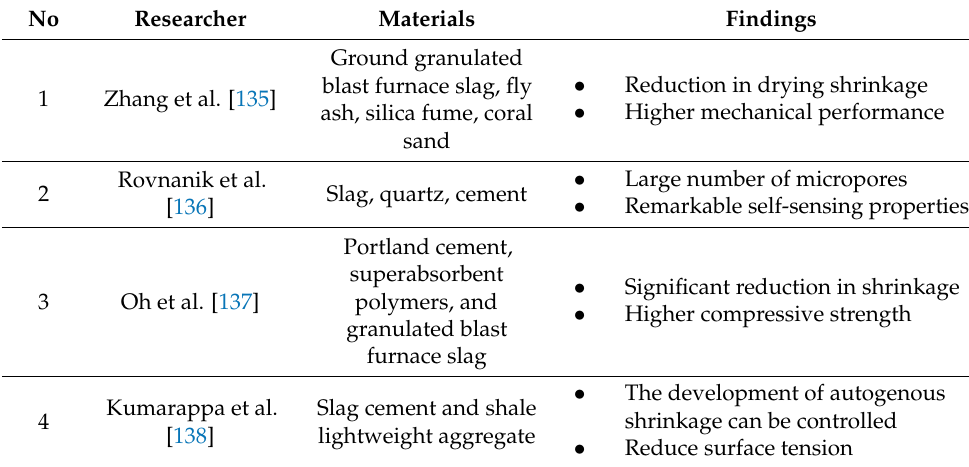
Table 8. Research work utilizing alkali-activated slag